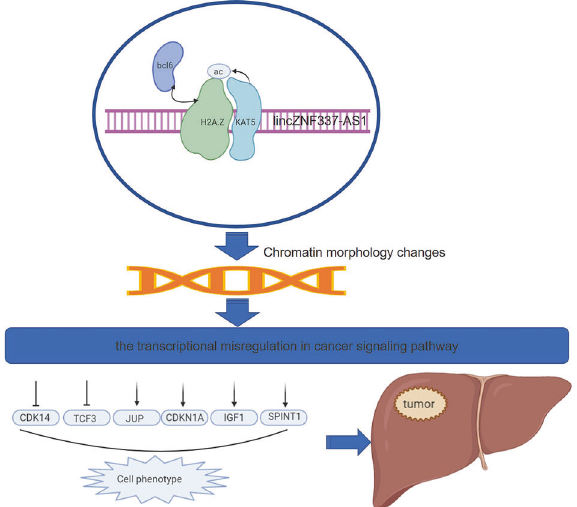
Fig. 8 Schematic diagram of the action mechanism of H2A.Z in HCC. H2A.Z acetylation by lincZNF337-AS1 via KAT5 implicated in the transcriptional misregulation in cancer signaling pathway in HCC. Fig.S1 Bioinformatics data analysis. a – b Heat maps and volcanograms of 23 pairs of HCC and paired paracancer tissues analyzed using RNA-seq in the GEO database(Software: R pheatmap and ggplot2, R package). c – d Heat maps and volcanograms of the three pairs of HCC and paired paracancer tissues analyzed by RNA-seq(Software: R pheatmap and ggplot2, R package). e Graphical comparison of the two groups of gene transcriptome data analyzed using RNA-seq, smooth curve, indicating high consistency of data(Software: ggplot2, R package) (Fig. S2) Flow cytometry analysis was conducted for detecting the cell cycle. The data are expressed in terms of mean ± SD (Student ’ s t -test; * P < 0.05; ** P < 0.01; n = 3 in each group) (Fig. S3) Veri fi ca- tion of downstream target genes of H2A.Z. a Schematic diagram of